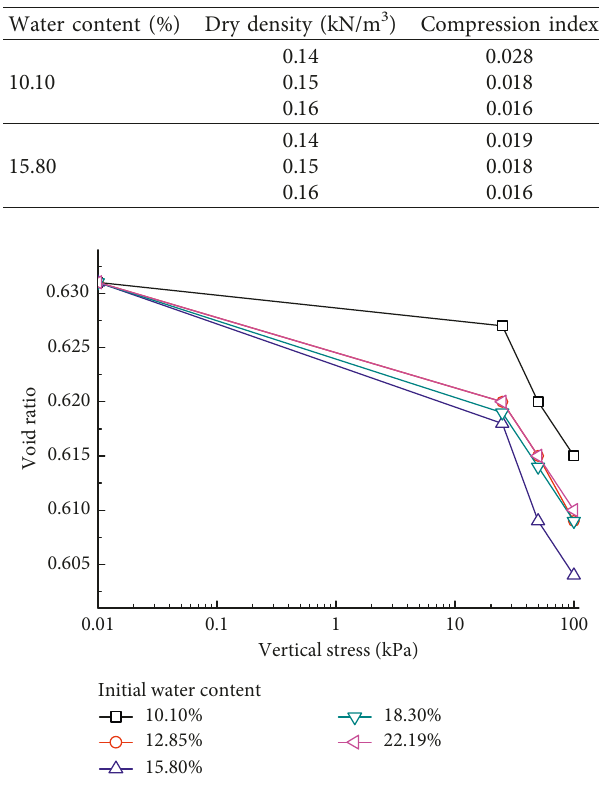
Figure 15: Relation between axial pressure and void ratio for dry density of 0.15kN/m 3